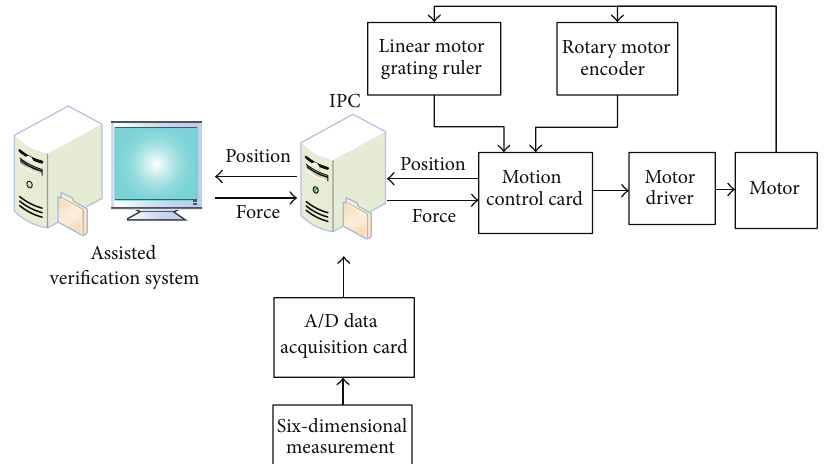
Figure 6: System composition schematic